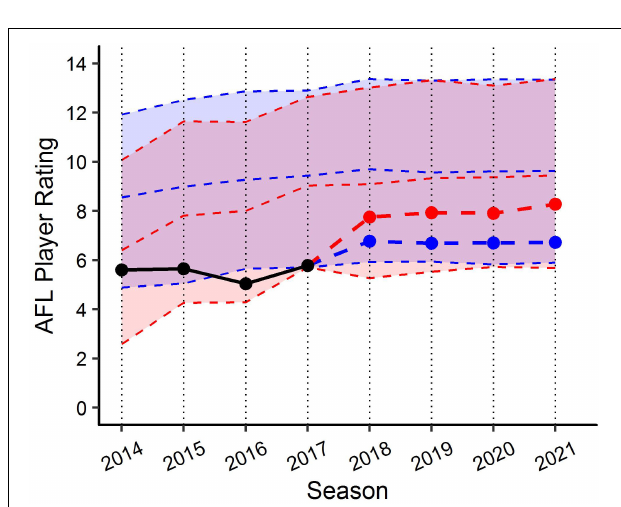
FIGURE 8 | Benchmark levels of AFL Player Ratings for a specific player using the both the age (blue) and experience (red) linear mixed models. Black line represents actual performance to 2017. Blue and red points indicate expectation of performance from 2018 using each the age and experience models, respectively. Similarly, each ribbon represents fixed effects estimates based on characteristics of same player in each model.